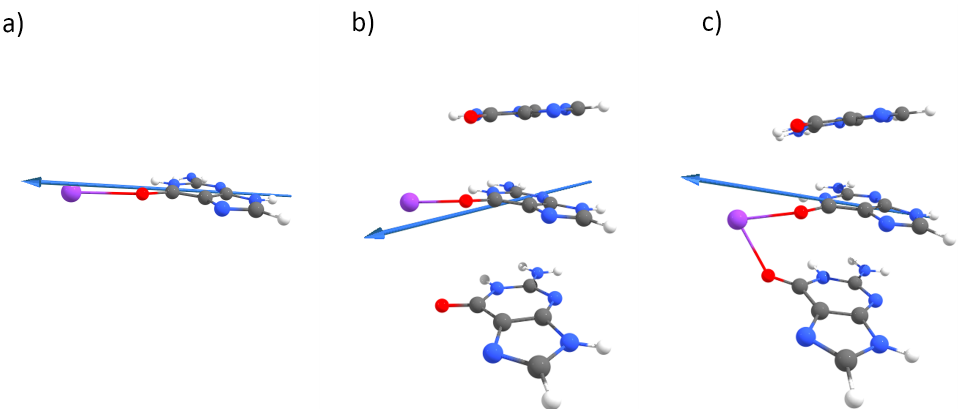
Figure A2. The dipole moments calculated at the QM level of theory for a single guanine coordinating K + ( a ), a three-guanine stack with K + situated in the plane of the middle guanine ( b ), and a three- guanine stack with K + situated between the planes of two guanines ( c ). Note the similarity in the values (i.e., the length of the vector) and directions of the dipole moments obtained for all three cases.